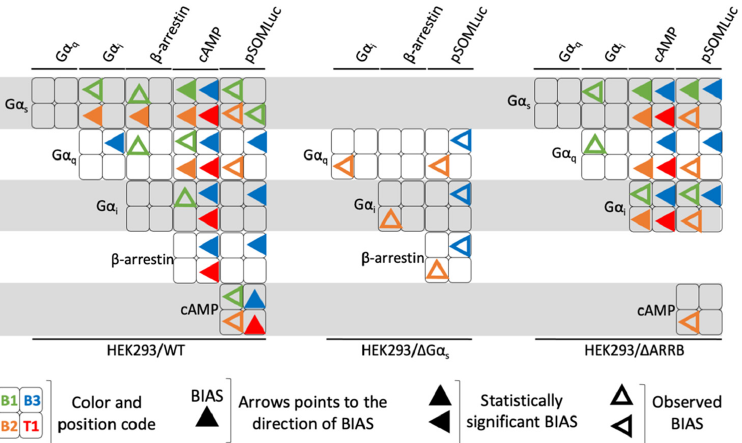
Figure 9. Graphic representation of the biased pharmacological behavior induced by LMW ligands. The biased pharmacological behavior of each LMW (represented in a color code, B1 = green, B2 = orange, B3 = blue and T1 = red) ligand is represented in the shape of an arrow pointing to the direction of bias for each of the pair of read-outs considered in the three cellular contexts. Statistically significant biases (full arrow) as well as observed biases (empty arrow) are shown.